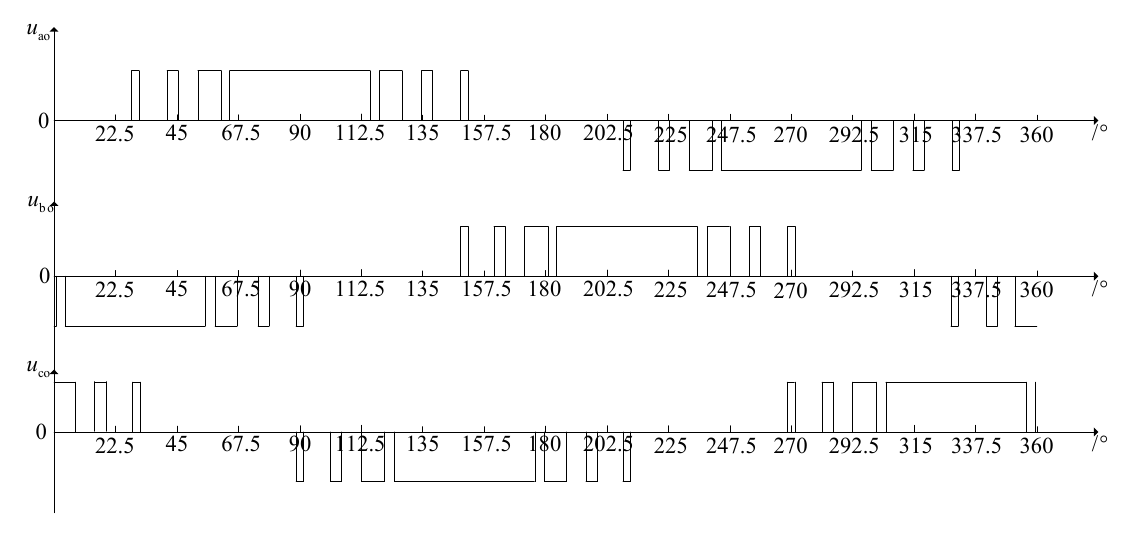
Figure 4. Three-phase output phase voltage waveform when switching angle N = 7.